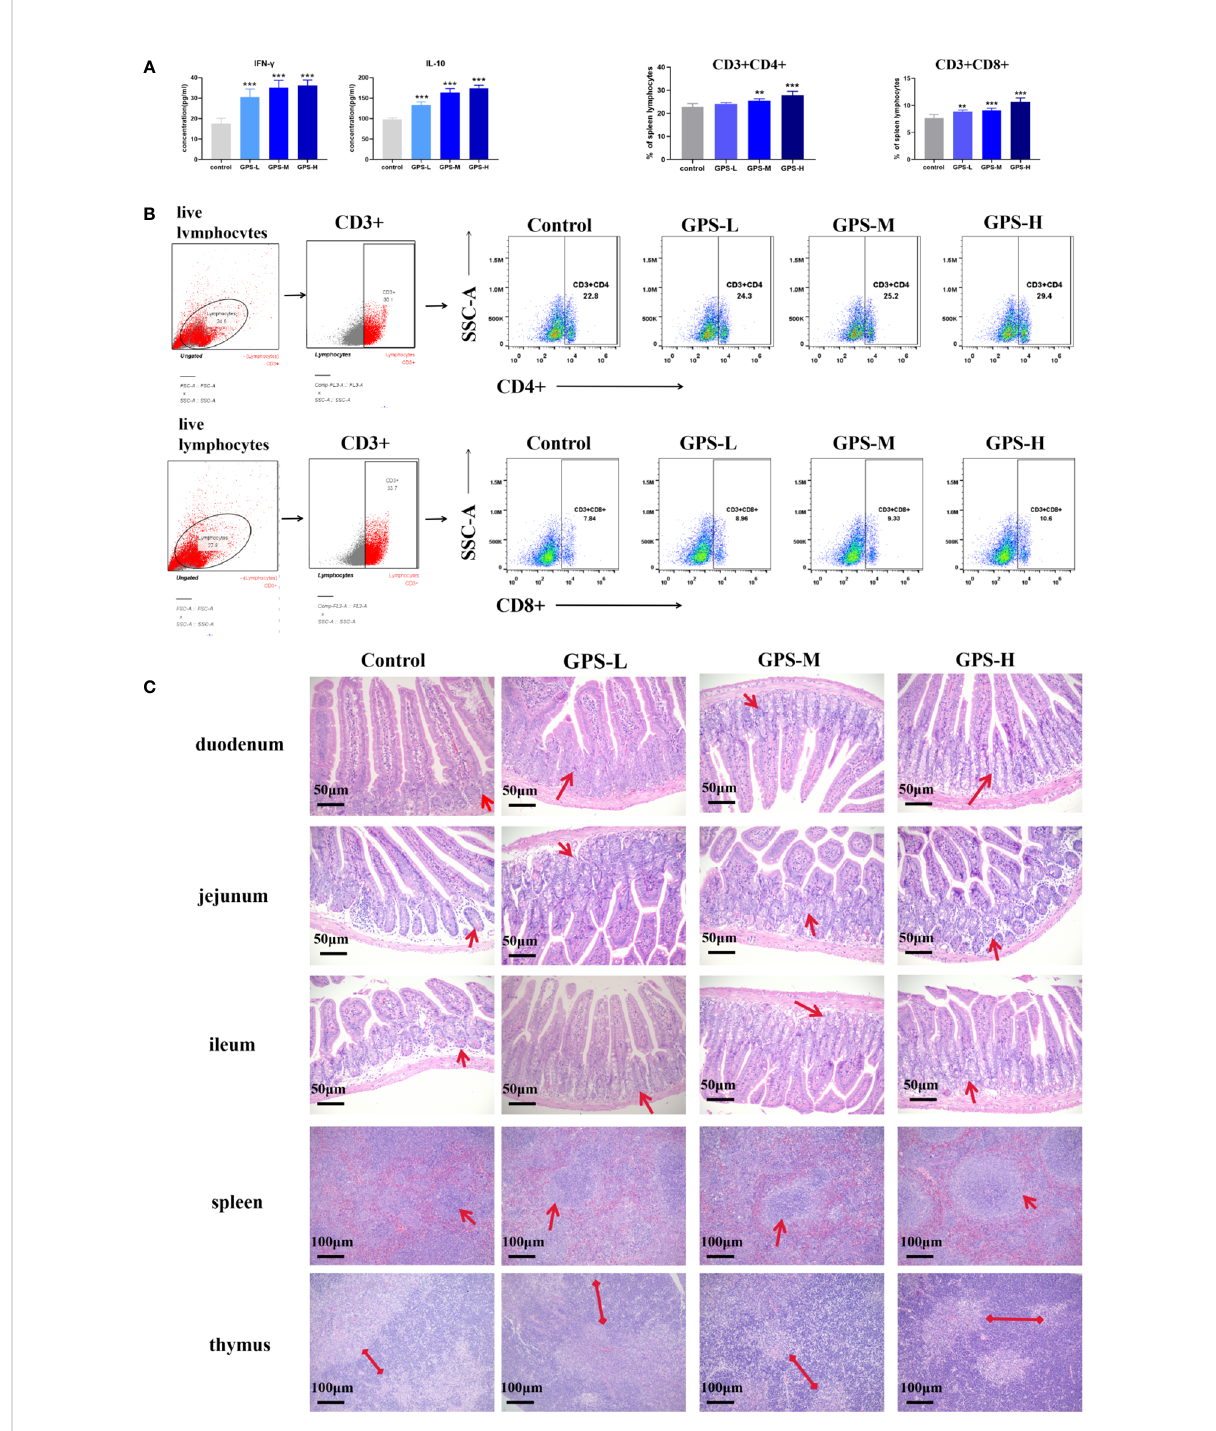
FIGURE 4 (A) Expression levels of IFN- g and IL-10 in serum of mice in each group after 14 days of administration (n = 5). (B) Histological analysis diagram of each small intestinal segment (200×),. and thymus and spleen (100×) at 14 days after drug administration. (C) Expression of CD3+CD4+ and CD3+CD8+ T cells in mouse spleen lymphocytes 14 days after administration (n = 5) and representative fl ow scatter plots of CD3+CD4+ and CD3+CD8+ T lymphocytes.Compared with blank group (Control): **p<0.01,